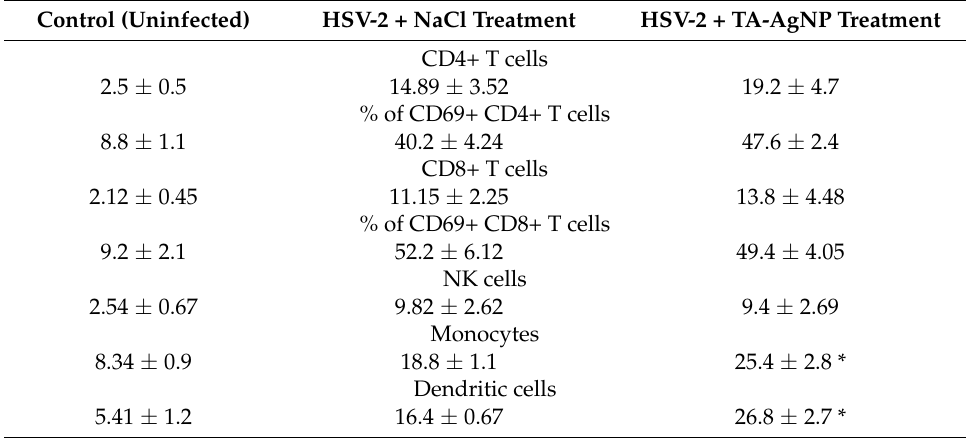
Table 1. Percentage of CD4+ T cells, CD8+ T cells, NK cells, CD4+ CD69+ T cells, CD8+ CD69+ T cells, dendritic cells, and monocytes in the vaginal tissue treated with NaCl or silver nanoparticles with tannic acid (TA-AgNPs) at 6, 24, and 48 h post-infection (p.i.) and isolated for further assays after eight days p.i. The results are expressed as mean ± standard error of the mean (SEM) for n = 10. and * = p <